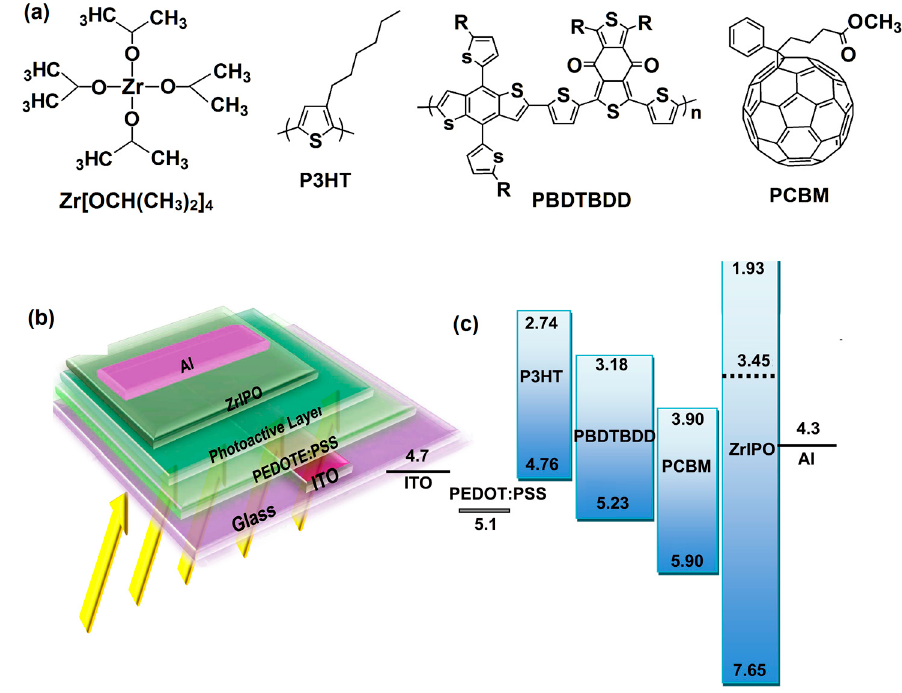
Figure 2. ( a ) Molecular structures of Zr[OCH(CH 3 ) 2 ] 4 , P3HT, PBDTBDD and PCBM; ( b ) Device structure of the PSCs; ( c ) Highest occupied molecular orbital (HOMO) and lowest unoccupied molecular orbital (LUMO) energy levels of the materials involved in the PSCs.